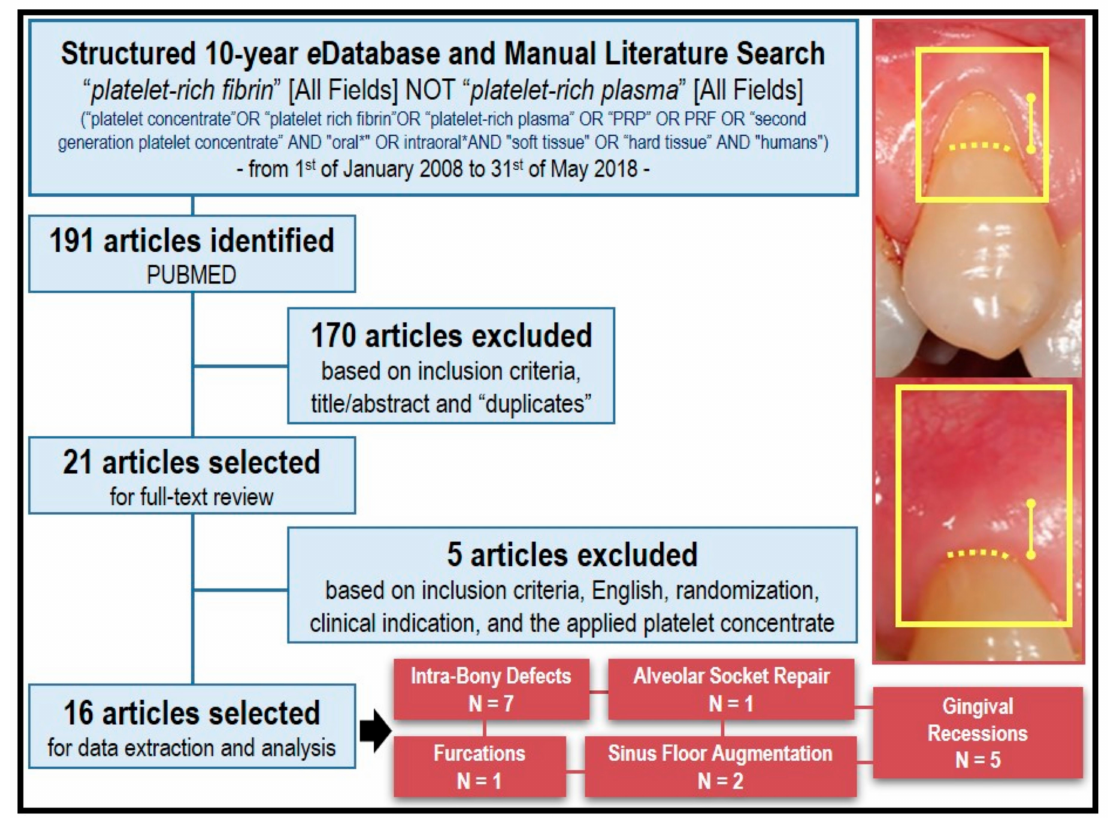
Figure 3. Flow chart of literature search strategy, hits, and included studies for data extraction